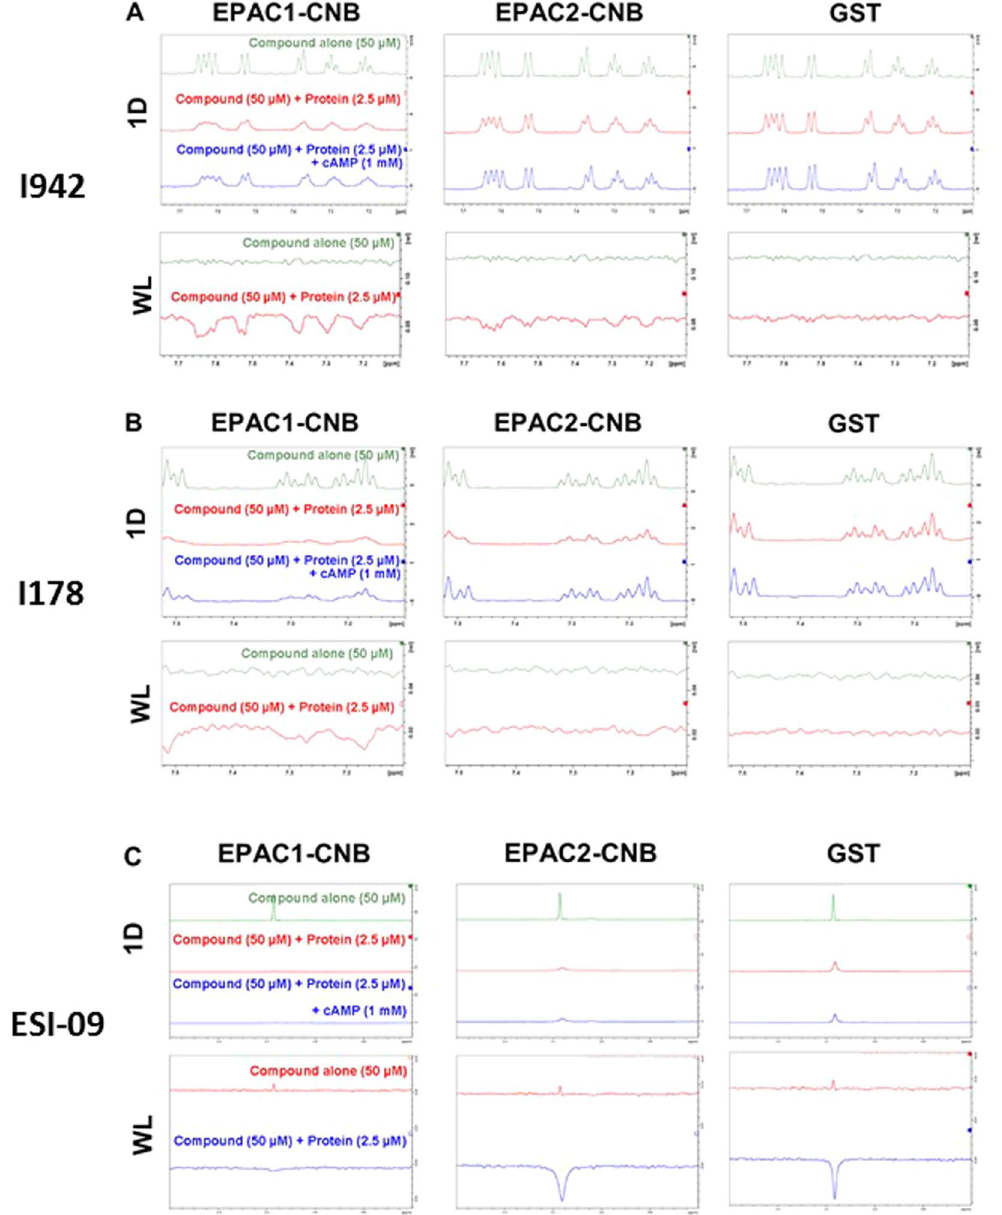
Figure 6. Ligand Observed NMR reveals Hit compounds Interact Directly with EPAC1-CNB and EPAC2- CNB, but not GST alone. ( A ) One dimensional proton (1D) and waterLOGSY (WL) spectra were performed on samples containing hit compound I942 (50 µ M) in the absence and presence of EPAC1-CNB, EPAC2-CNB or GST alone, as indicated (2.5 µ M). A representative region of the I942 spectrum is shown (7.1–7.75 ppm). Interaction between compound and protein was assessed through comparison of the compound alone and protein-compound sample spectra. The NMR data are representative of data collected at several protein and ligand concentrations. ( B ) 1D and WL spectra were performed on samples containing I178 (50 µ M) in the absence and presence of EPAC1-CNB, EPAC2-CNB or GST alone, as indicated (2.5 µ M). A representative region of the I178 spectrum is shown (7.1–7.51 ppm). ( C ) 1D and WL spectra were performed on samples containing the commercially available EPAC selective inhibitor ESI-09 (50 µ M) in the absence and presence of EPAC1-CNB, EPAC2-CNB or GST alone, as indicated (2.5 µ M). A representative region of the ESI-09 spectrum is shown (0.6–1.2